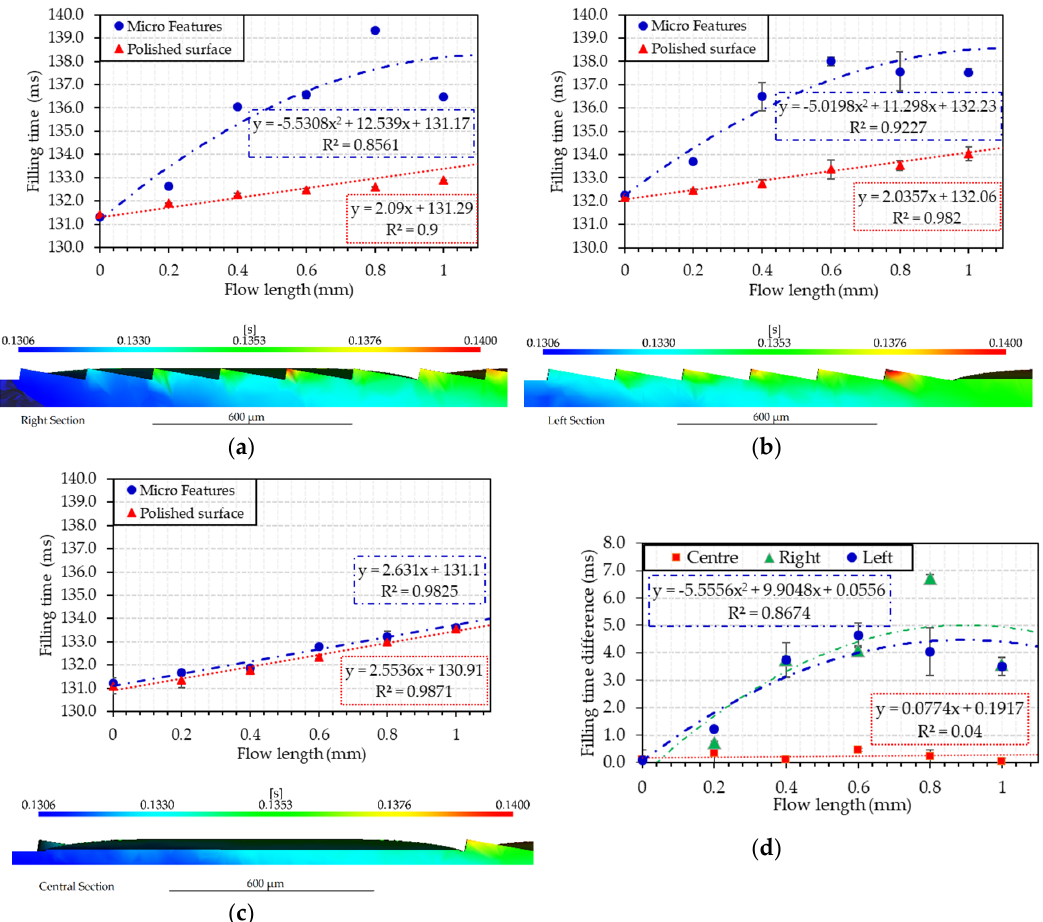
Figure 17. Filling time comparison from the microfeature and bottom polished surface as a function of the flow length for the right ( a ), left ( b ), and central ( c ) section of Case 3 with the summary difference of filling time for each condition ( d ).